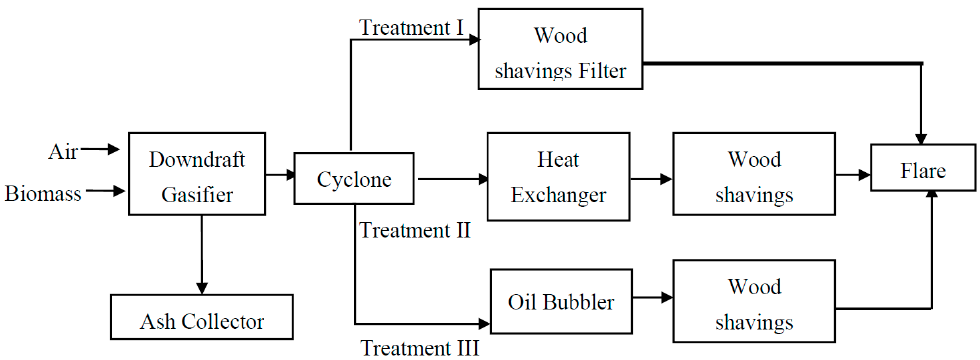
Figure 1. Schematic diagram of the three gas cleaning treatments: ( I ) wood shavings filter; ( II ) heat exchanger + wood shavings filter; and ( III ) oil bubbler + wood shavings filter. Table 2. Gasifier operating conditions.